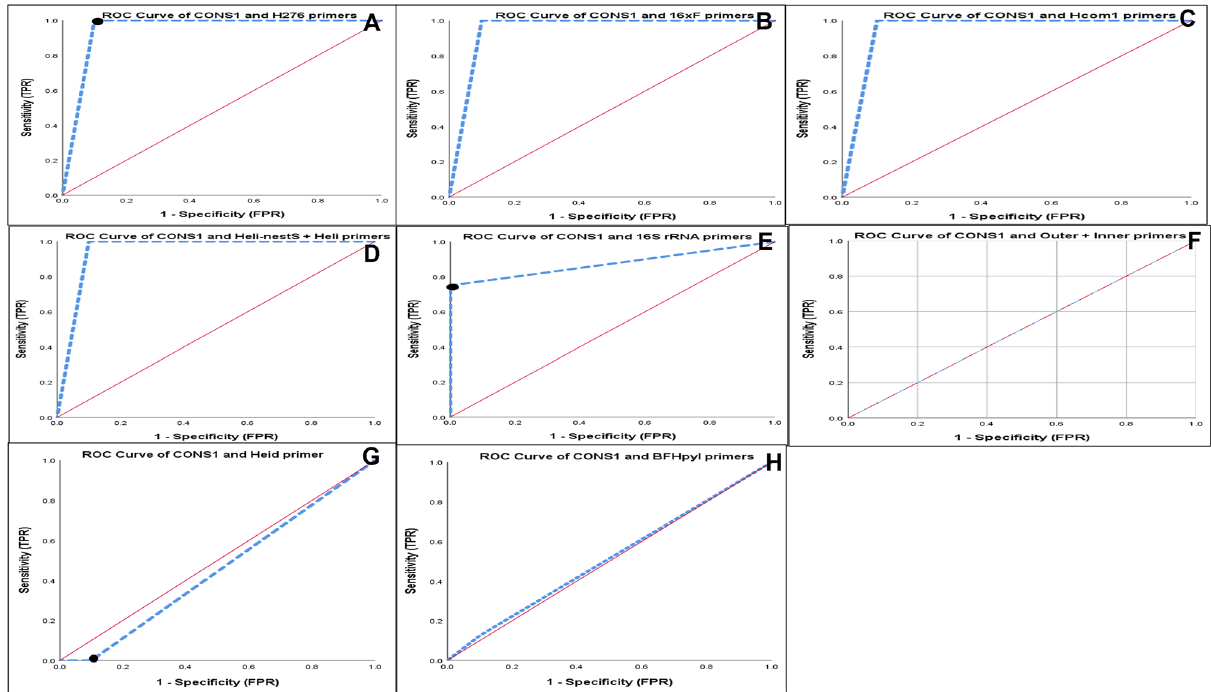
Figure 2. ROC curve of laboratory comparison of all primers using Helicobacter spp. (n = 8) and non- Helicobacter spp. (n = 10). Null hypothesis: true area = 0.5, AUC: Area under the curve. ( A ), ROC curve of ConsH and H276 primers, AUC represents the accuracy of the screening test (0.950). ( B ), ROC curve of ConsH and 16srRNA (a) primers, AUC represents the accuracy of the screening test (0.950). ( C ), ROC curve of ConsH and Hcom1 primers, AUC represents the accuracy of the screening test (0.950). ( D ), ROC curve of ConsH and Heli-nestS + Heli primers, AUC represents the accuracy of the screening test (0.950). E, ROC curve of ConsH and 16S rRNA primers, AUC represents the accuracy of the screening test (0.875). ( F ), ROC curve of ConsH and Outer + Inner primers, AUC represents the accuracy of the screening test (0.500). ( G ), ROC curve of ConsH and Heid primers, AUC represents the accuracy of the screening test (0.450). ( H ), ROC curve of ConsH and BFHpyl primers, AUC represents the accuracy of the screening test (0.513).